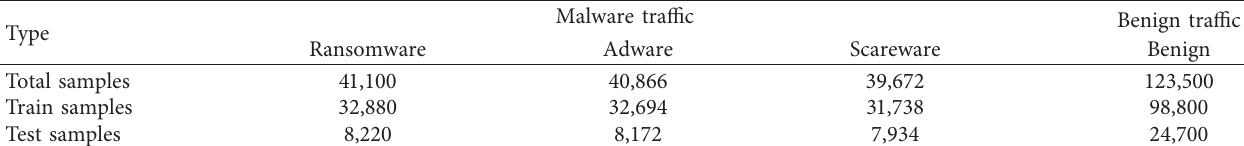
Table 3: Distribution of observations that were used for all